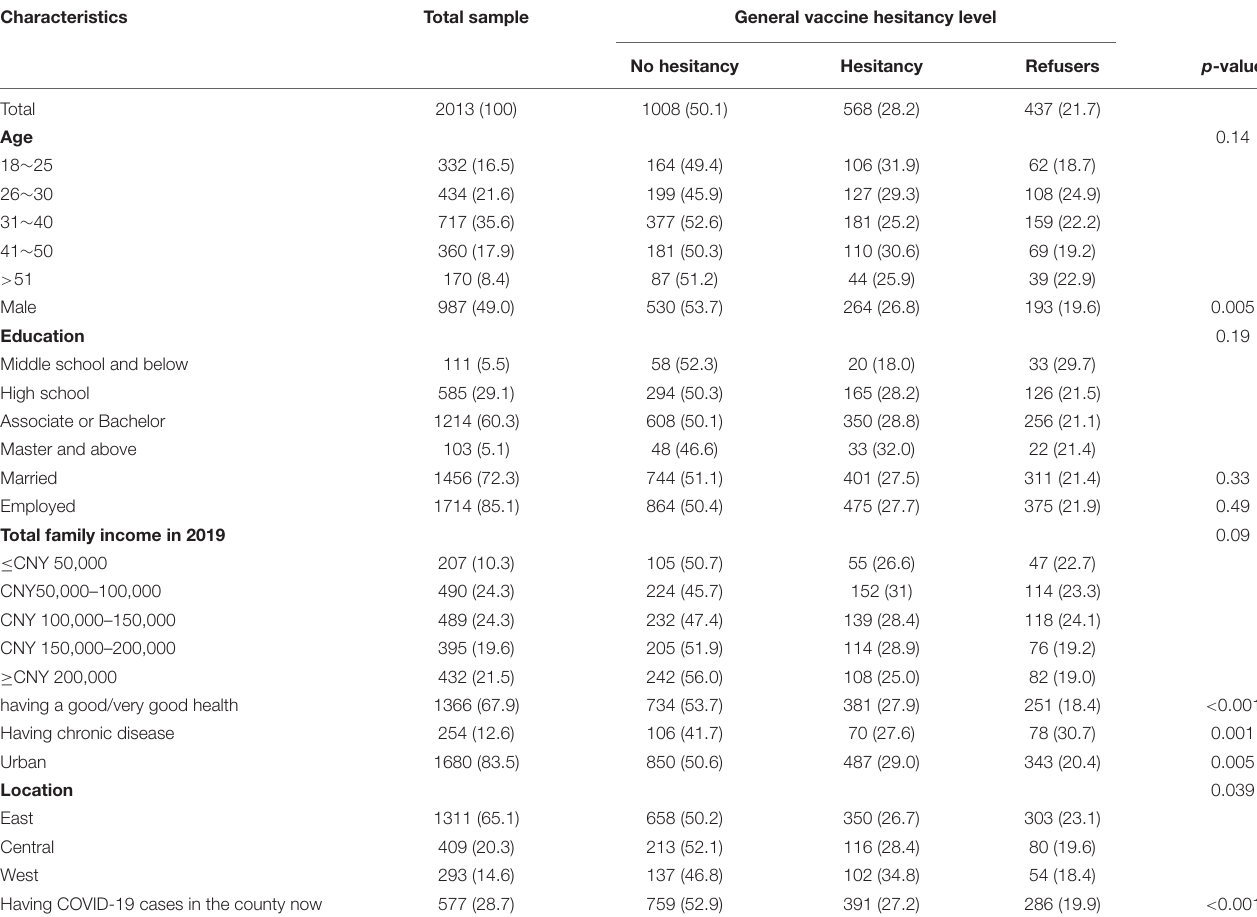
TABLE 1 | Participants’ characteristics and general vaccine hesitancy level, n